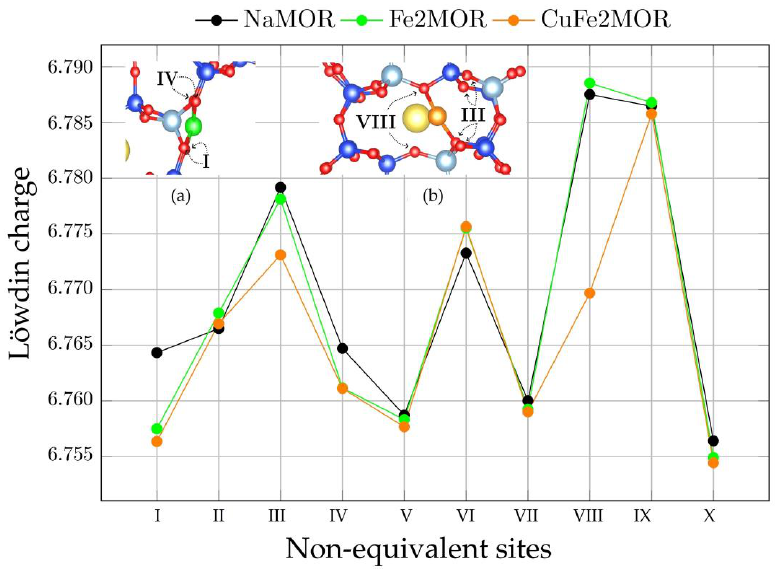
Figure 6. Löwdin charge computed for three distinct configurations: NaMOR, Fe2MOR, and CuFe2MOR. Insets ( a ) and ( b ) show the nearest neighbor oxygen atoms (and their respective non-equivalent site) for Fe and Cu cations, respectively.